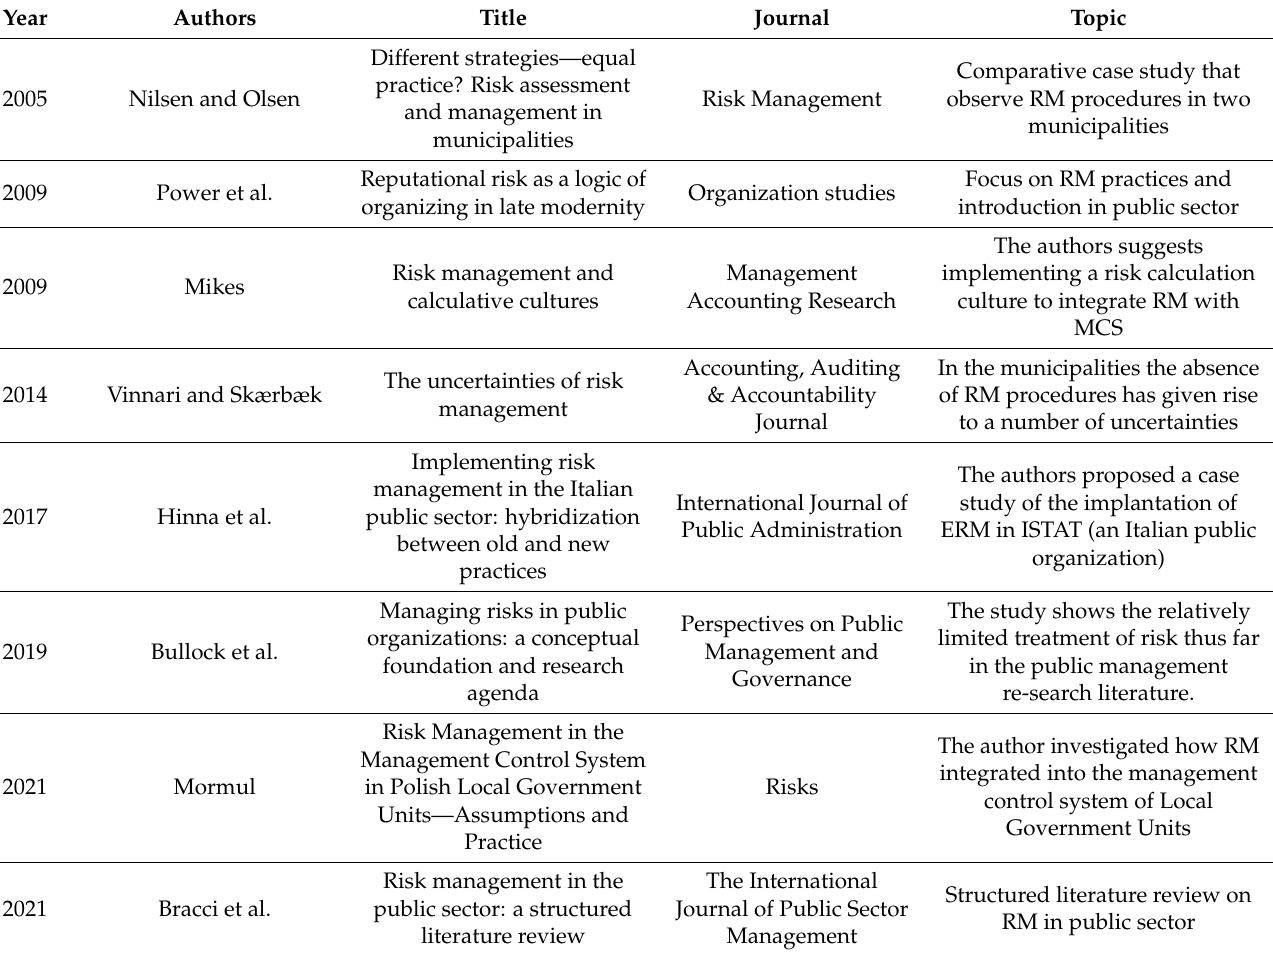
Table 1. Main literature on Risk Management in practice the Public Sector of recent